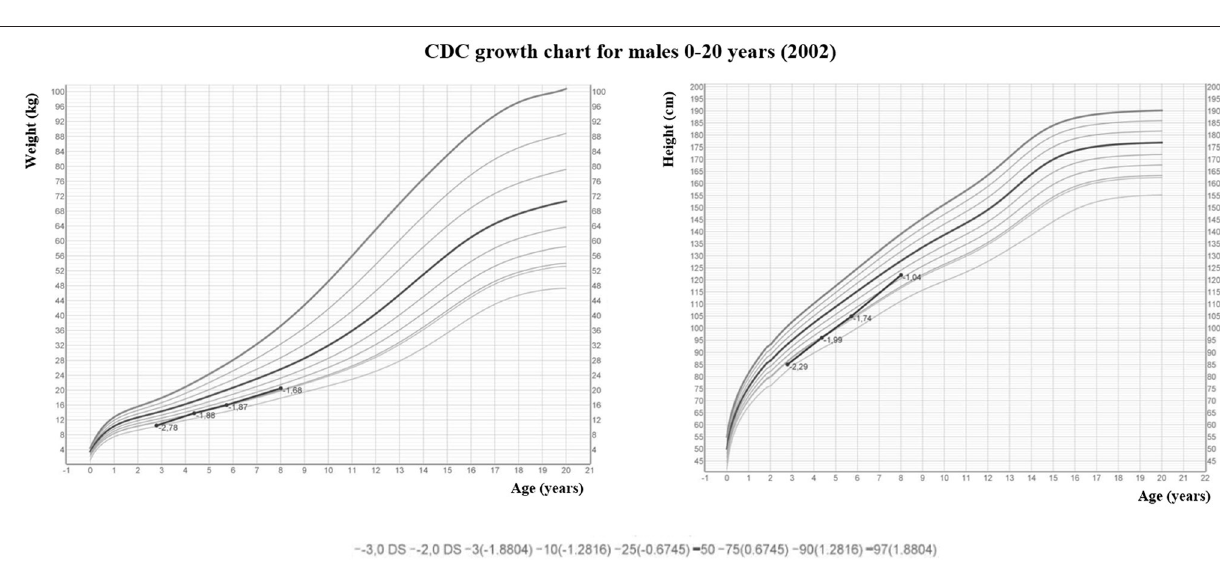
FIGURE 2 | Growth curves of Case